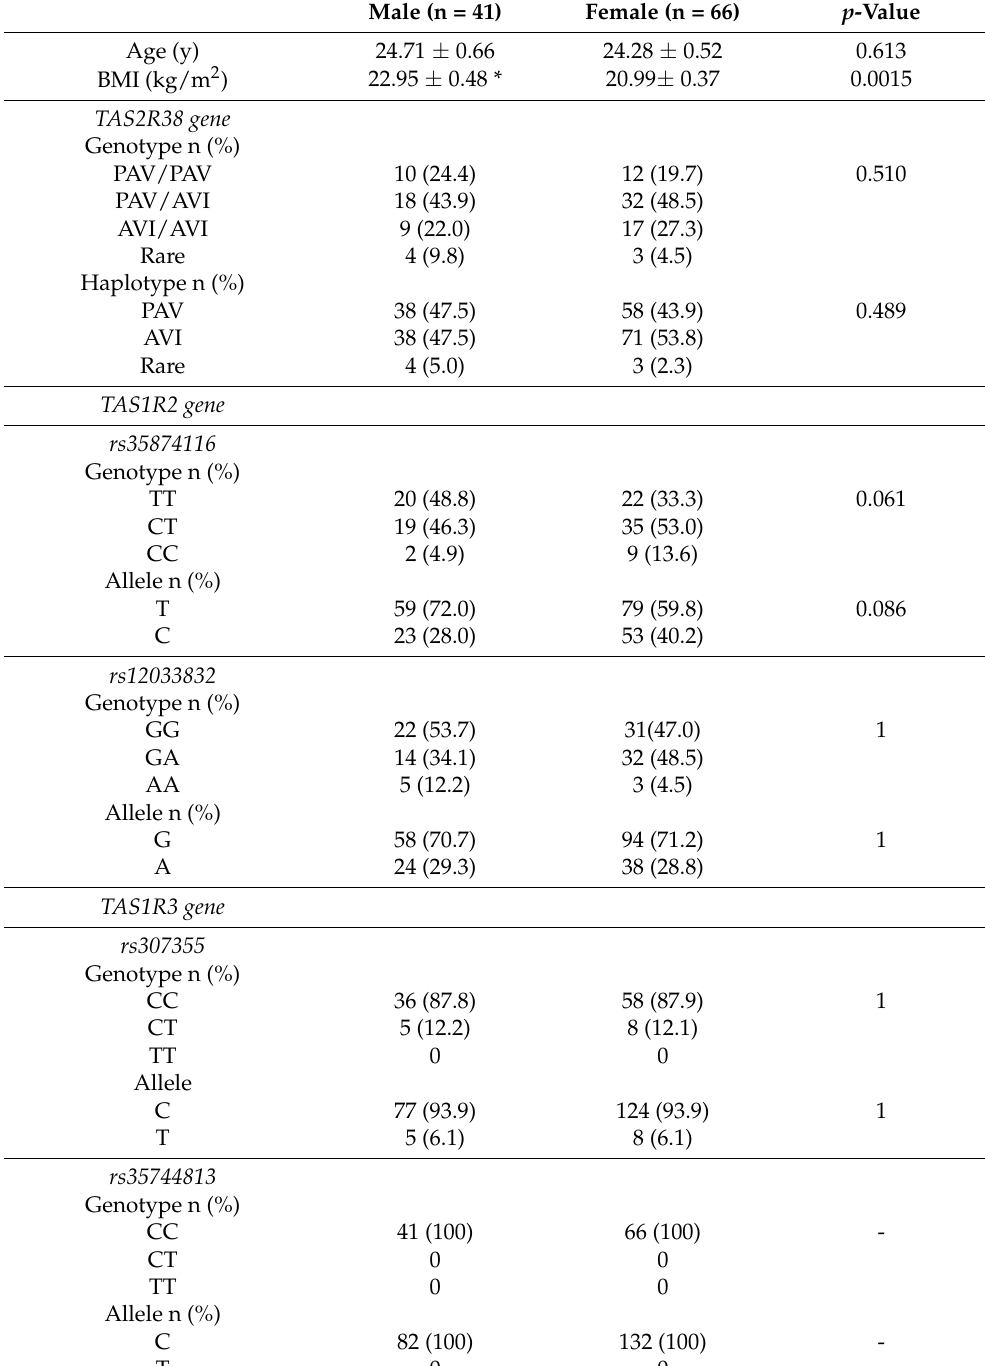
Table 1. Demographic, anthropometric, and genetic features of subjects according to